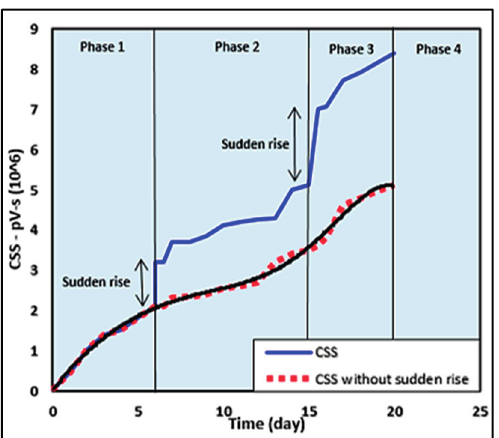
Figure 6. The variations in CSS parameter, which are similar to the curve of typical corrosion of steel reinforcement (Reproduced and modified from